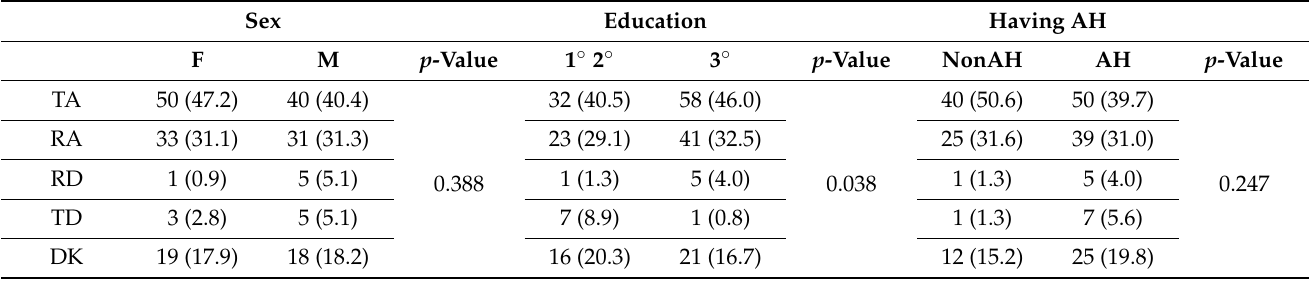
Table 5. Excess salt in the diet as a factor that increases the incidence of hypertension by gender, education, and having hypertension (N =